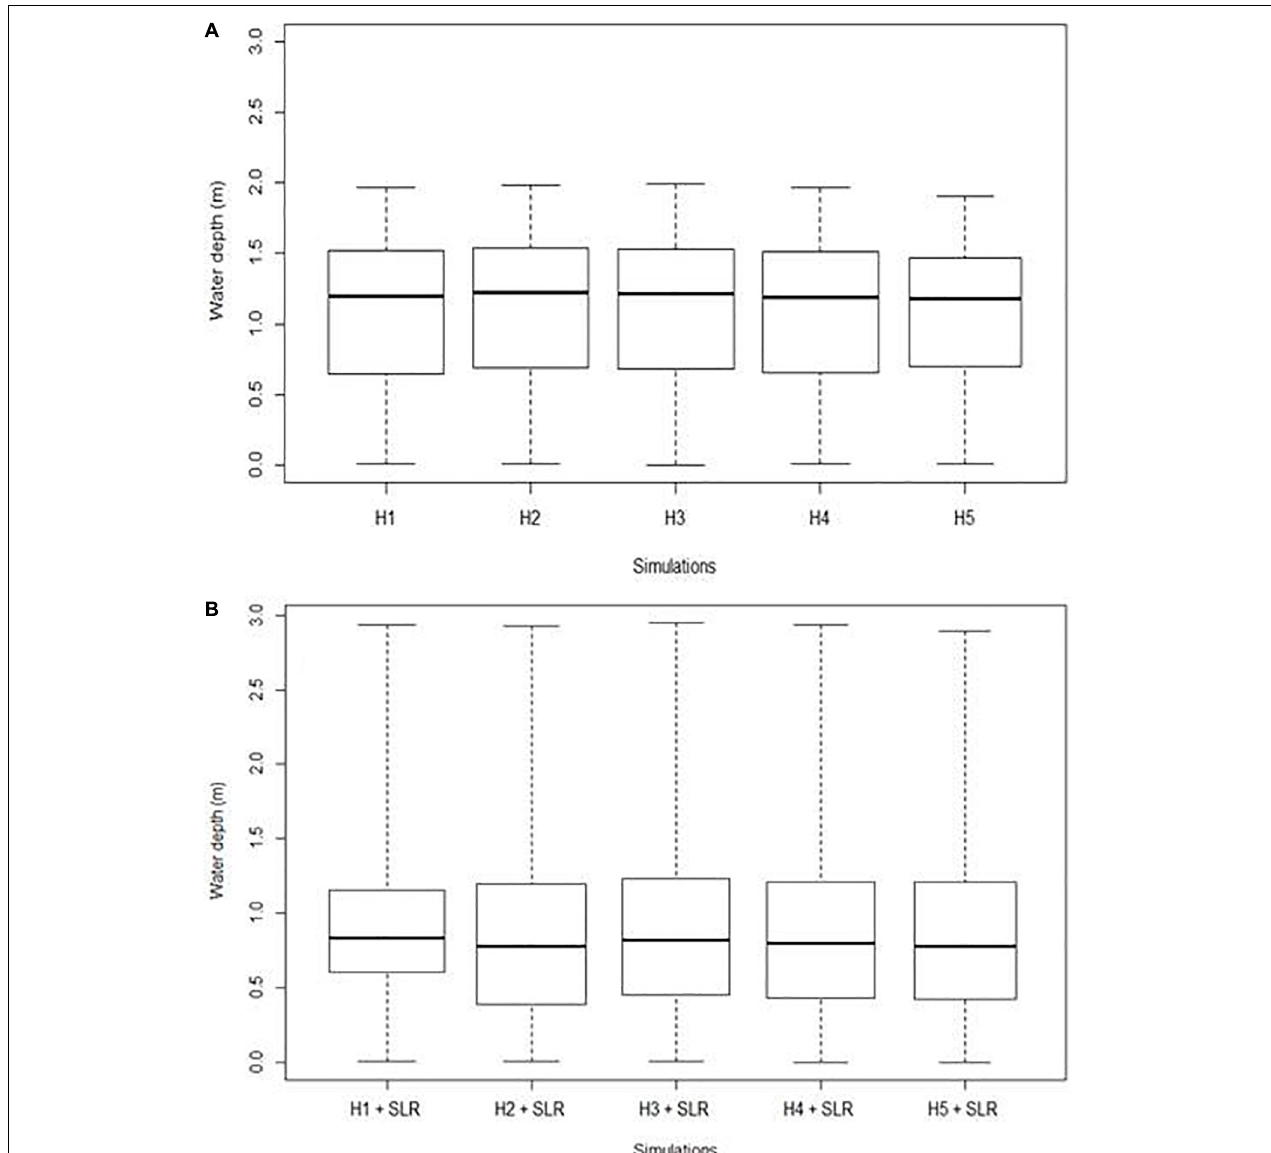
FIGURE 6 | Flood depth for all hydrographs with water levels corresponding to a 200-year return period (A) and combined with 1 m sea-level rise (B) – The box shows values between the upper (75%) and lower (25%) quartiles. The black line inside the box indicates the median. The whiskers extent to the maximum and